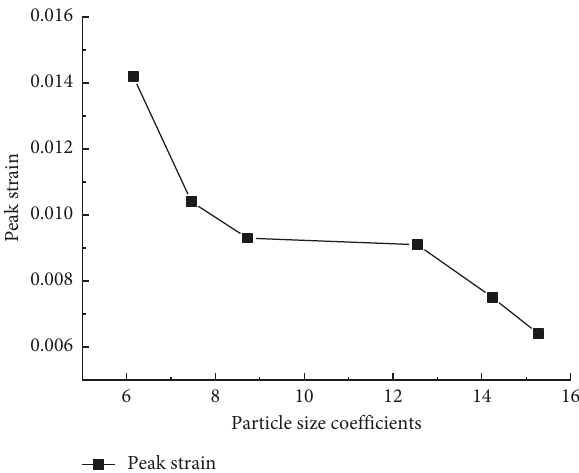
Figure 19: Relationship between particle size coefficient and peak